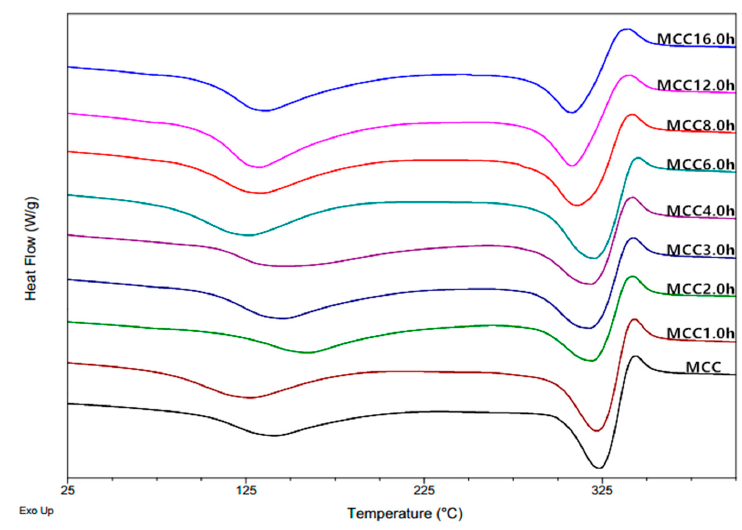
Figure 4. DSC curves of MCC samples with different ball milling time.